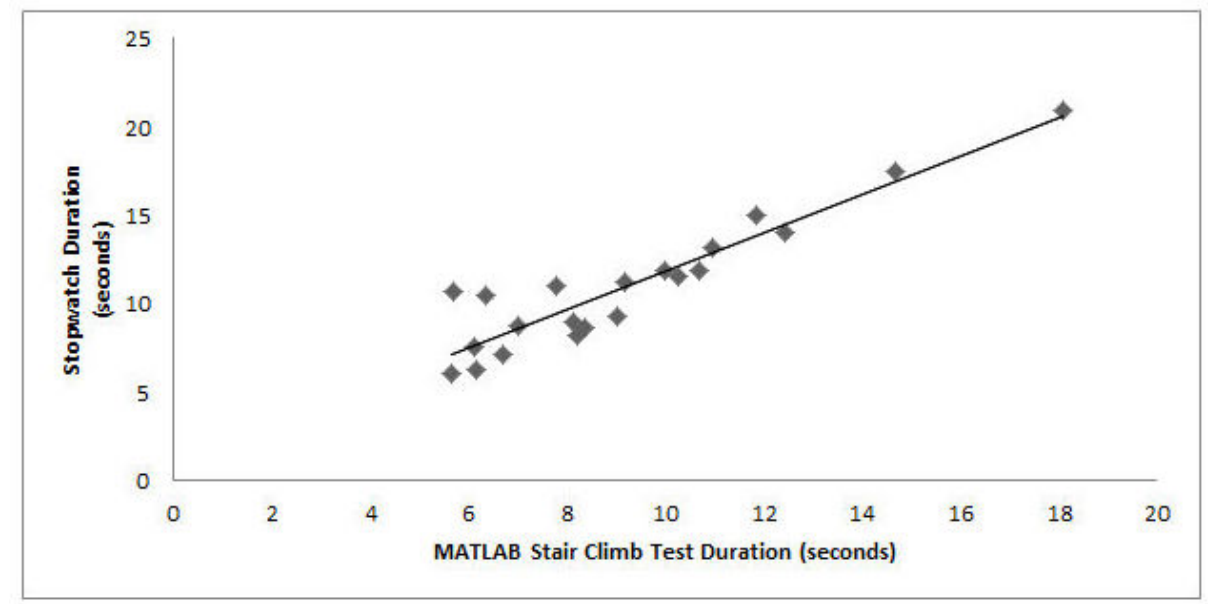
Figure 7. Regression between MATLAB-generated test duration and stopwatch-measured time during the 12-step Stair Climb Test (n=21; Pearson's correlation coefficient=.865).